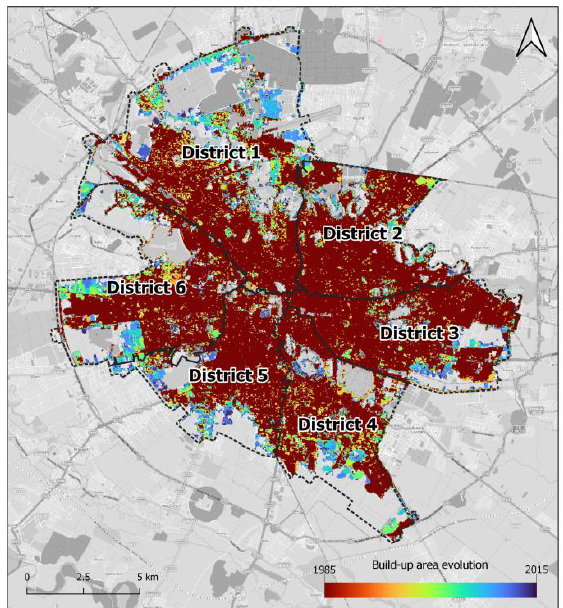
Figure 7 . Bucharest’s urban expansion by districts between 1985 and 2015 (data source: WSF Evolution, DLR, CC-BY